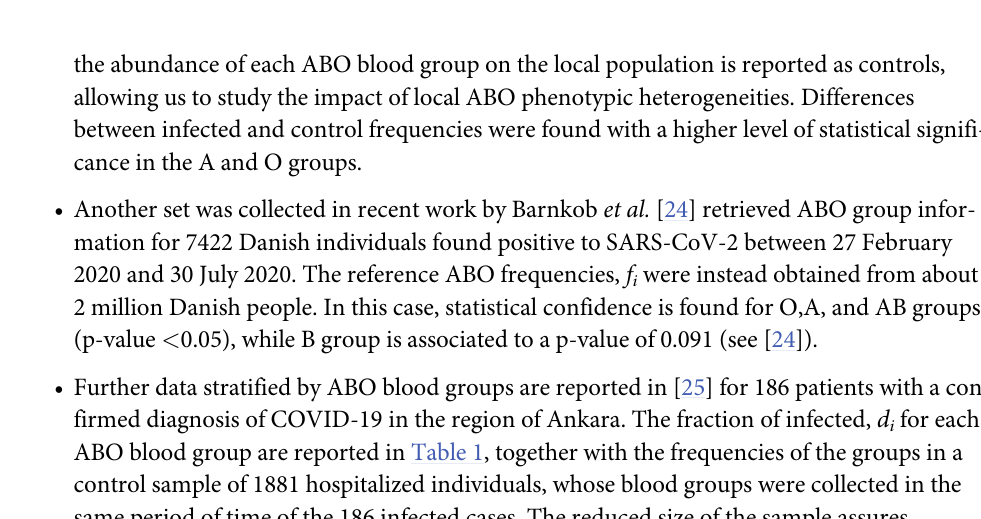
represent the susceptibility of the population to become infected. T Dataset